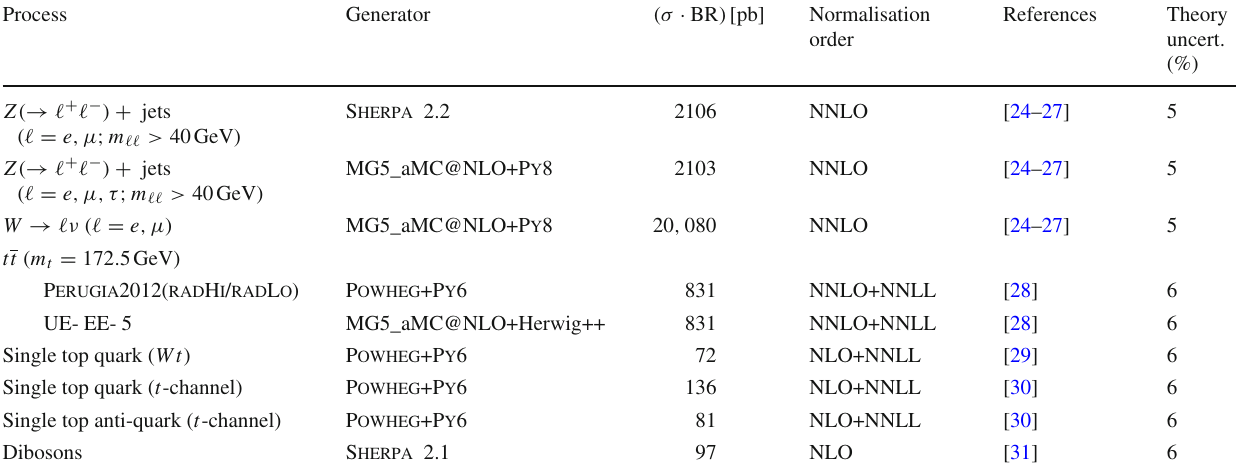
Table 1 Signal and background Monte Carlo samples and the genera- tors used in the simulation. Each sample is normalised to the appropri- ate production cross section σ and multiplied by the relevant branching ratios (BR) per lepton flavour for this sample, as shown in the third column. For W -boson and top-quark production, contributions from higher-order QCD corrections were calculated following the references giveninthefifthcolumnforthestatedorder.Similarly,for Z -bosonpro- duction, higher-order QCD corrections were evaluated in the dilepton invariant mass range 66 < m (cid:10)(cid:10) < 116GeV following the references